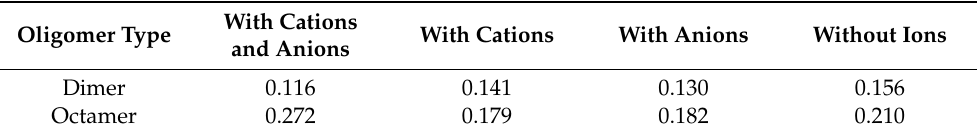
Table 3. RMSF of C α atoms of lysozyme dimer and octamer for the cases with the different occupancy of cations (Na + ) and anions (Cl − ).